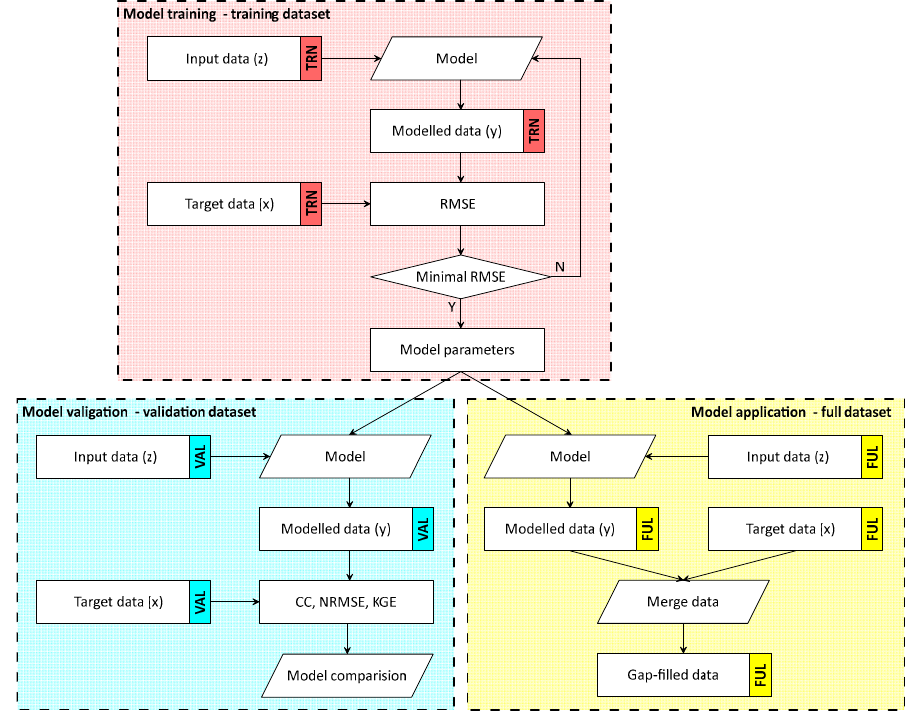
Figure 2. The flowchart of the data processing. TRN—training dataset, VAL—validation dataset, FUL—full dataset.